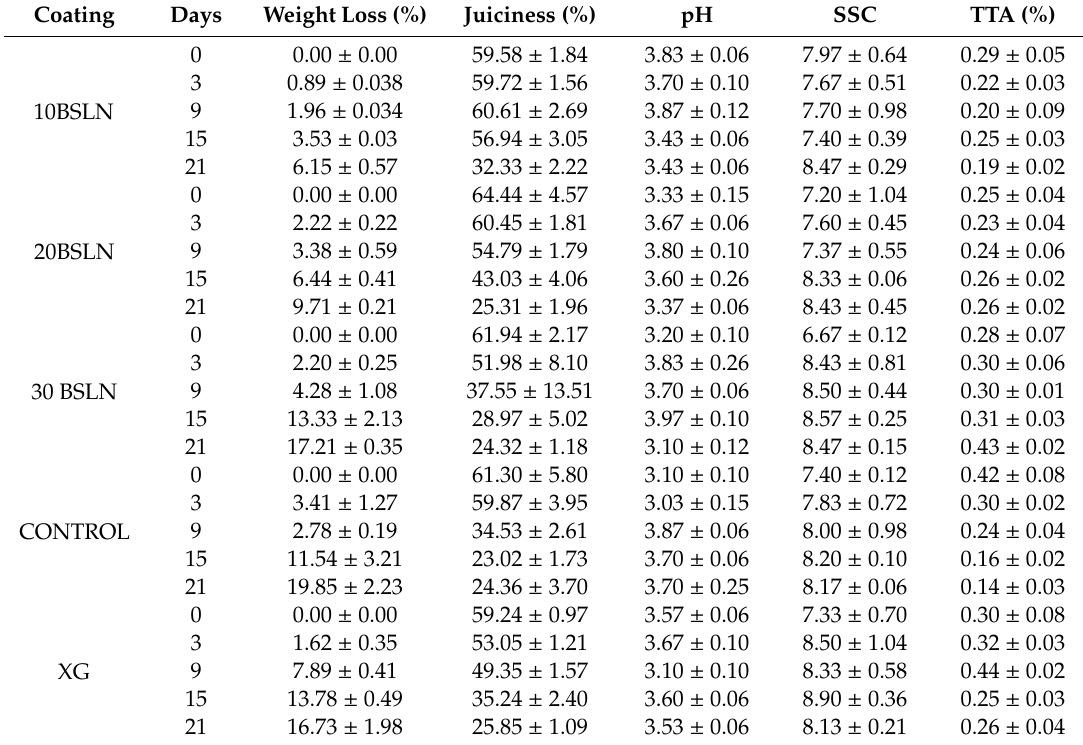
Table 1. Physicochemical changes in strawberries stored at 4 ◦ C as a function of SLN content on the coating with a continuous matrix of xanthan